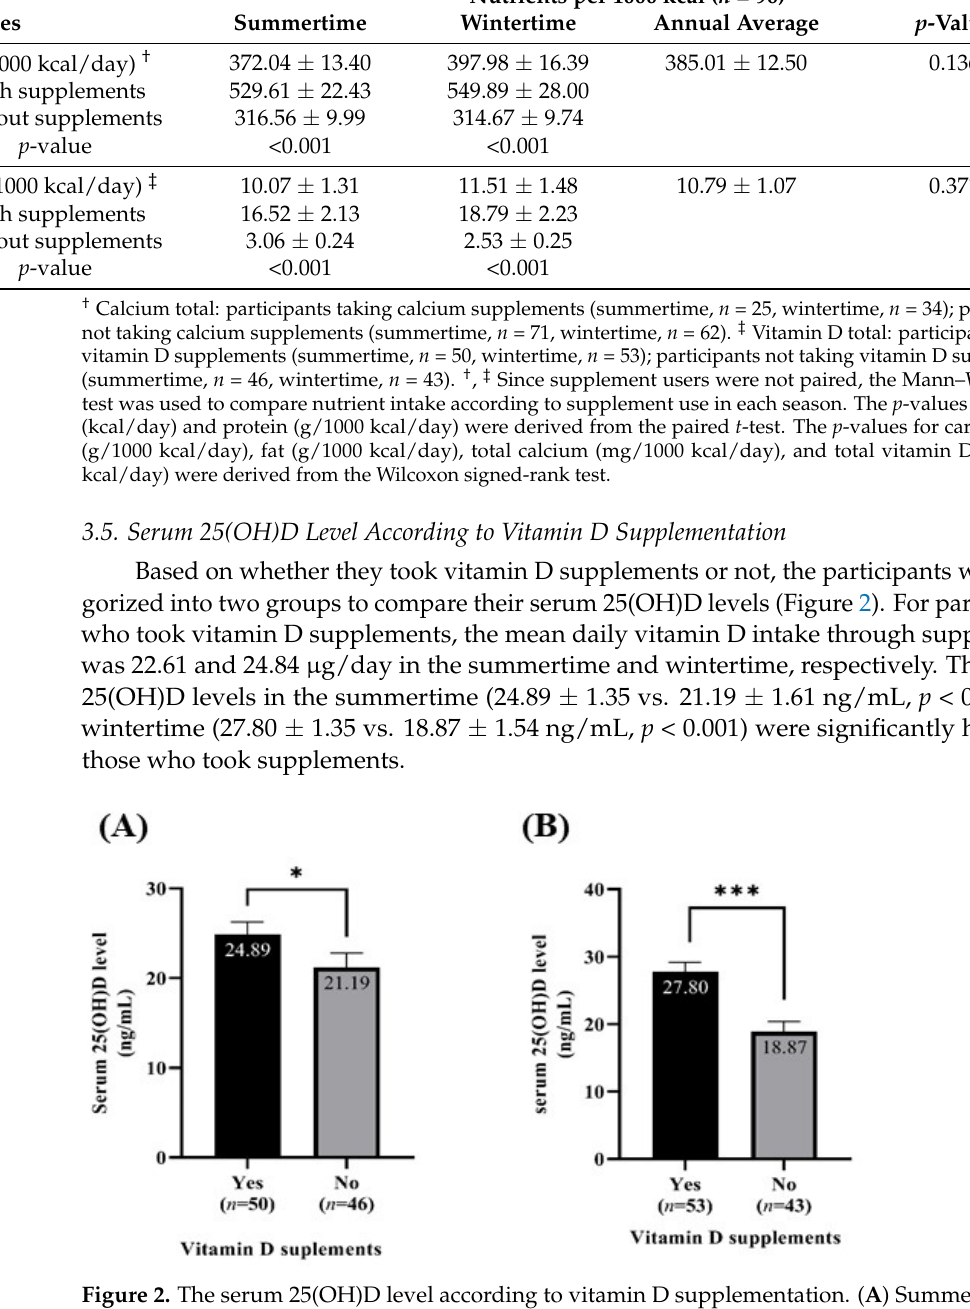
Figure 2. The serum 25(OH)D level according to vitamin D supplementation. ( A ) Summertime; ( B ) Wintertime. Mean ± S.E.; The mean value of vitamin D intake through vitamin D supplements: summertime, 22.61 ± 3.09 µg/day; wintertime, 24.84 ± 3.53 µg/day. The p -values were derived from the Mann–Whitney U test.; * p < 0.05, *** p < 0.001.